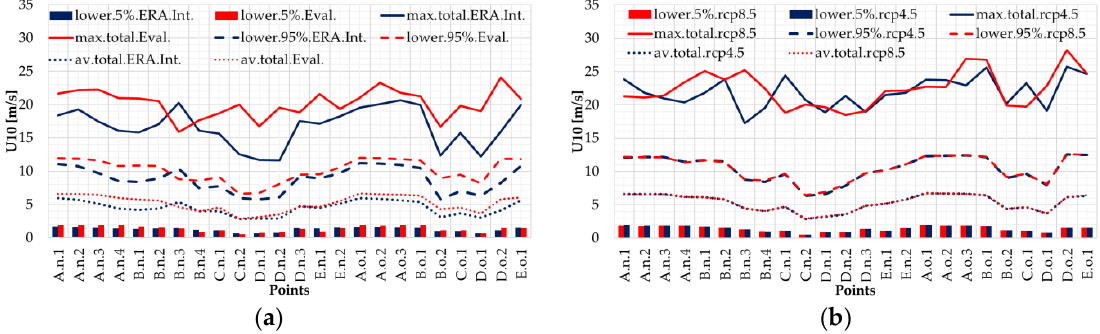
Figure 2. Analysis of the wind speed at 10 m ( U 10) height in terms of maximum values (max.total), average values (av.total), 5th percentile (lower.5%) and 95th percentile (lower.95%) values, corresponding to the reference points. ( a ) Comparison between ECMWF ERA-Interim (ERA.Int.) and EURO-CORDEX Evaluation (Eval.) wind speeds, for the 30-year period (1981–2010); ( b ) Comparison between EURO-CORDEX wind speeds corresponding to RCP4.5 and RCP8.5 scenarios for a 30-year period (2021–2050).